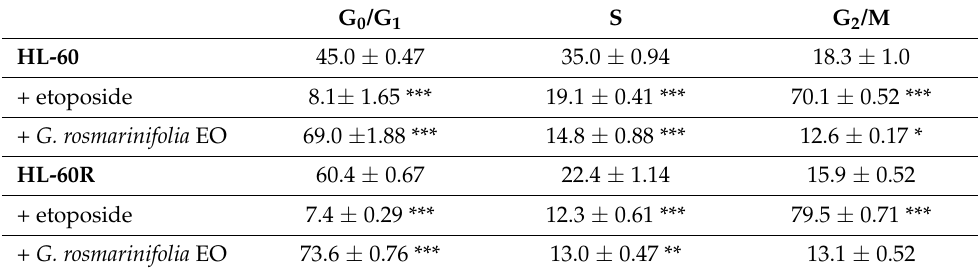
Table 3. Cell-cycle changes induced by G. rosmarinifolia EO in HL-60 and HL-60R cells.